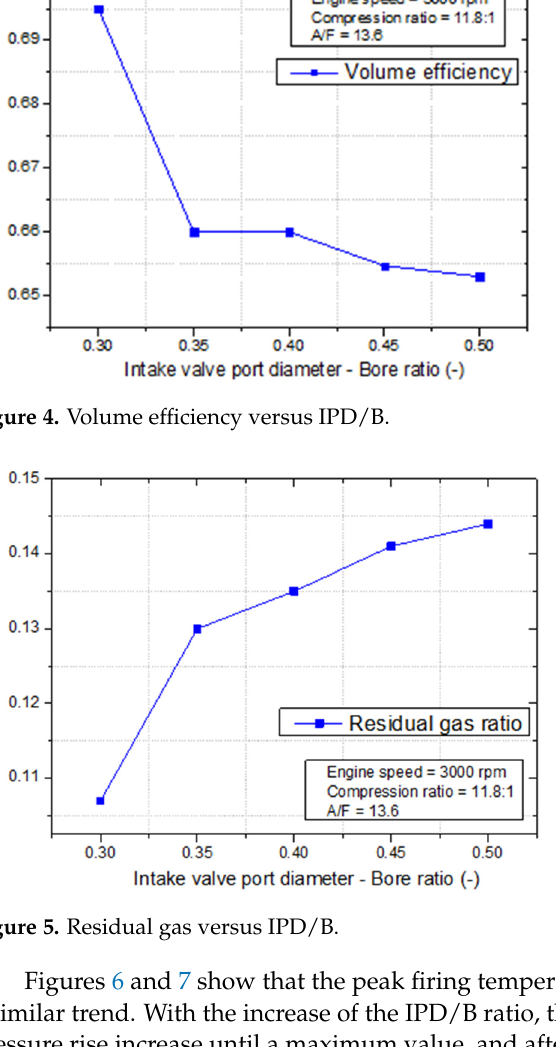
Figure 6. Peak temperature versus IPD/B.